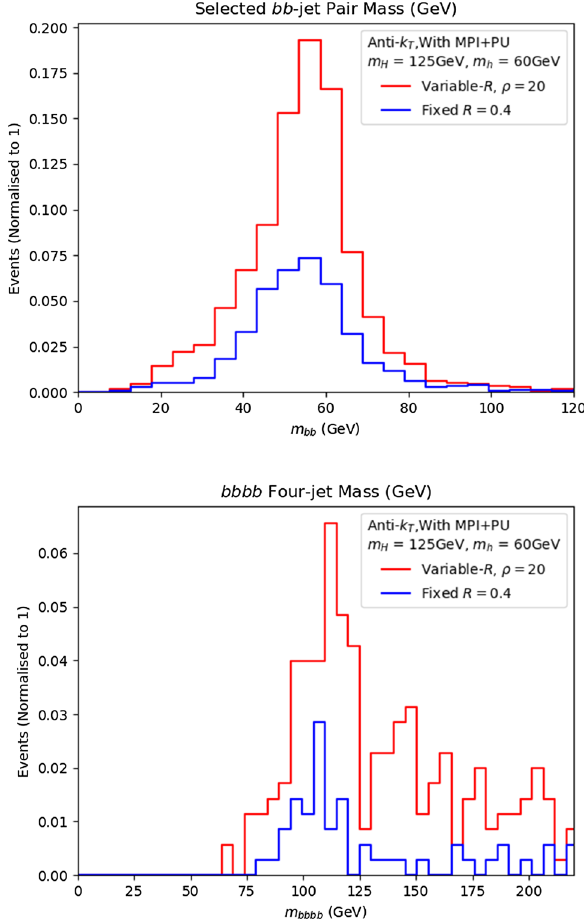
Fig. 16 Upper panel: the b -dijet invariant masses for BP2, using variable- R and fixed- R clustering, when considering the effect of PU and MPIs. Lower panel: the same for the 4 b -jet invariant mass